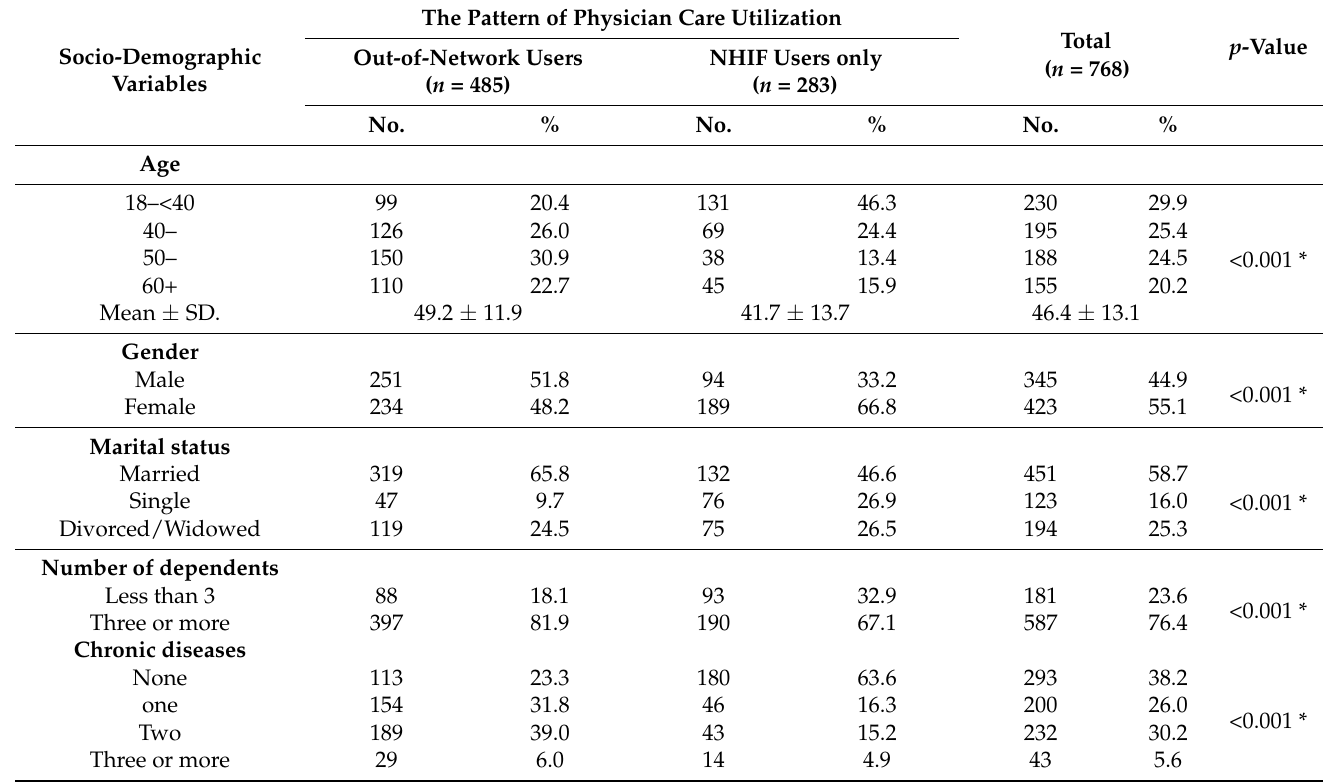
Table 1. Socio-demographic factors associated with the pattern of physician care